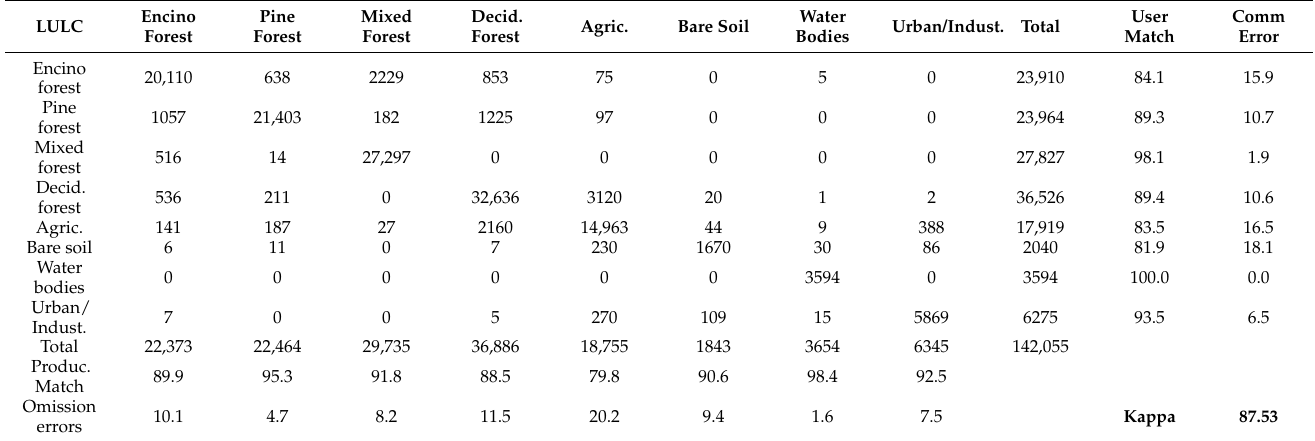
Table 5. Confusion matrix of the test date LULC through change-detection map compared with the ground-truth data. LULC Encino Forest Pine Forest